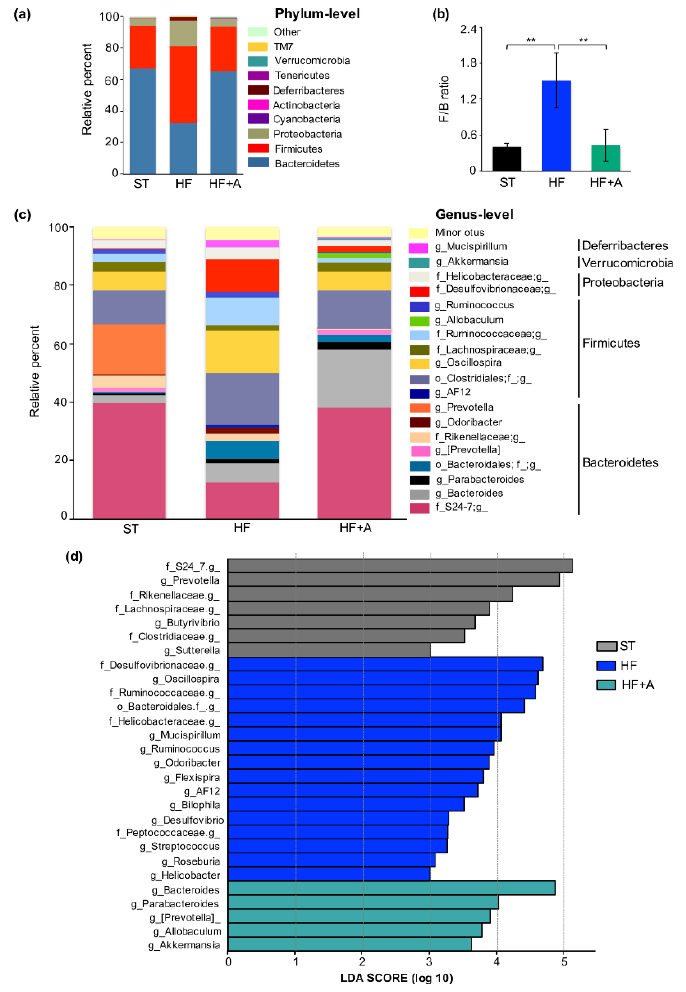
Figure 1. Differences in relative abundance of bacterial taxa in mice fed with high-fat diet plus agavins supplementation. ( a ) Bacterial taxa plot at the phylum level. ( b ) Firmicutes/Bacteroidetes ratio. Data are shown as average ± SD, and were analyzed using one-way ANOVA, followed by Tukey multiple comparison test. Significant difference is indicated by ** p < 0.01. ( c ) Bacterial taxa plot at the genus level. Each taxa > 1% of the average relative abundance in groups is indicated by a different color. Taxa are reported at the lowest identifiable level, indicated by the letter preceding the underscore: f, family; g, genus. ( d ) Histogram of biomarker bacteria in each group. Linear Discriminant Analysis (LDA) Effect Size (> 3.0 fold) was used to determine statistically significant biomarkers. HF (mice fed with a high-fat diet); HF+A (mice fed with a high-fat diet plus agavins); ST (mice fed with a standard diet); for each experimental group ( n = 5).